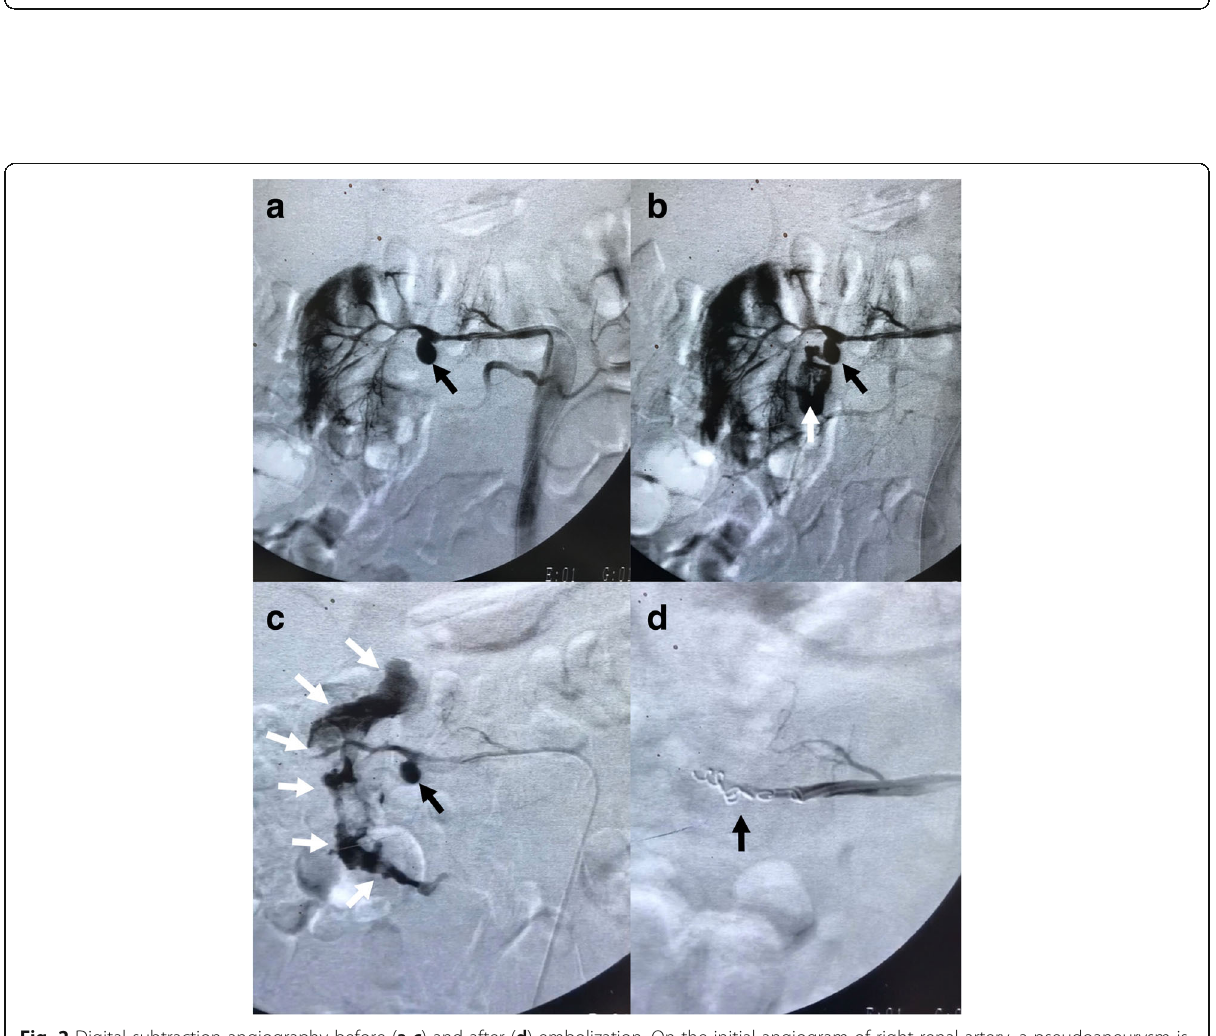
Fig. 2 Digital subtraction angiography before ( a - c ) and after ( d ) embolization. On the initial angiogram of right renal artery, a pseudoaneurysm is seen (black arrows in a to c ) in the distal extra-renal segment of right renal artery. During contrast injection, rupture and contrast extravasation is noted (white arrow in b ). The extravasated contrast enters the duodenum and forms the contour of this structure at later phases of injection (white arrows in c ). Post-embolization angiogram ( d ) shows adequate embolization and exclusion of pseudoaneurysm. The coils are seen in the renal artery (black arrow in d